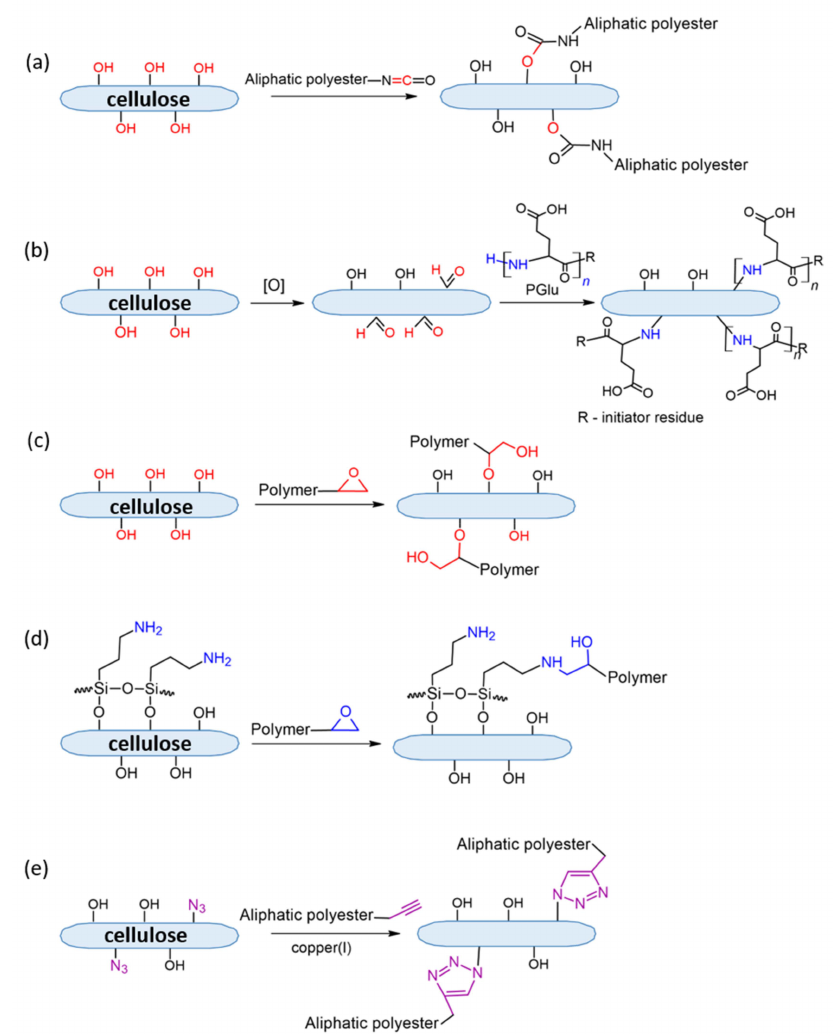
Figure 13. Possible ways of modifying the cellulose surface with macromolecular compounds by grafting “to” (Table 9): ( a ) attachment of polymer containing isocyanate group, ( b ) interaction of polymer amines with aldehyde groups of preoxidized cellulose, ( c , d ) modification of cellulose with epoxy-bearing polymers, ( e ) modification via